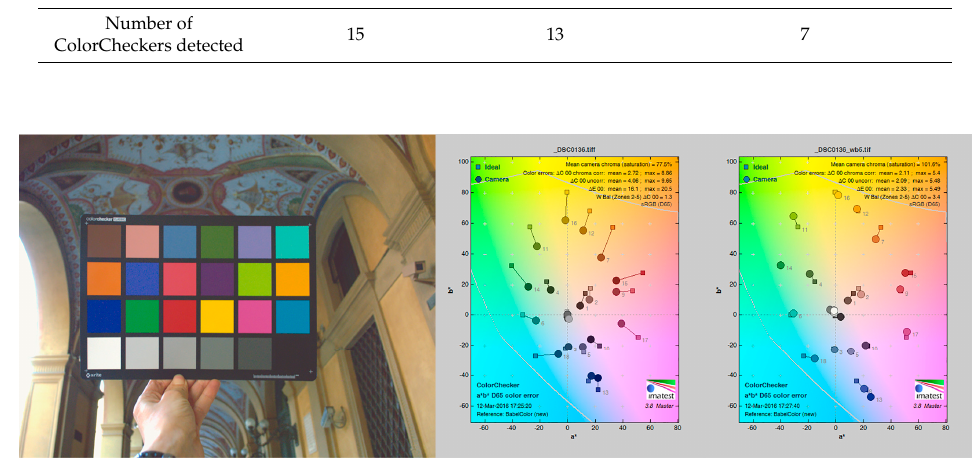
Figure 6. Mean camera chroma relative to the mean ideal chroma in the CIE color metric and the color analysis for the left image: manual color balance (center) and automated workflow results (right). Table 2. Δ E * 00 evaluation.